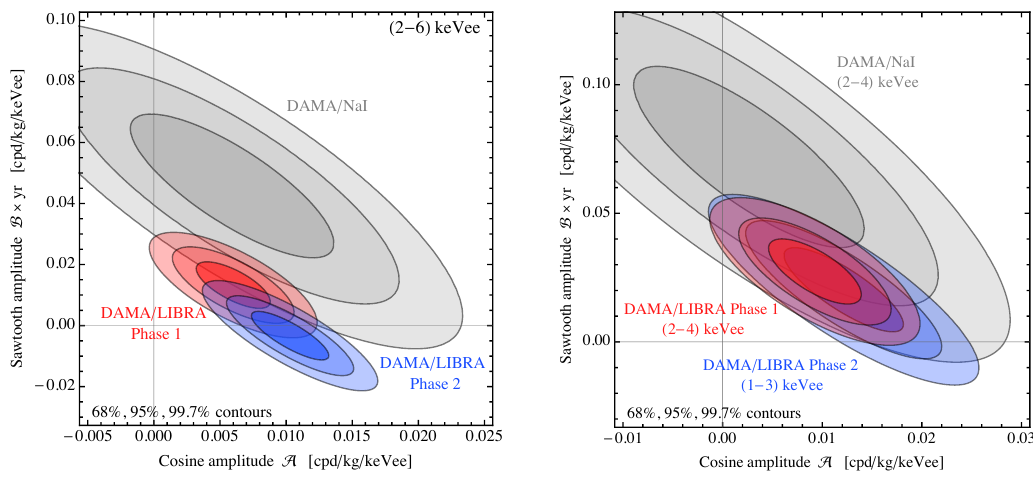
Figure 6 . Fit of the DAMA residual rates to a sawtooth plus a cosine with period and phase as predicted by DM. Left: (cid:12)t of residuals in the (2{ 6) keVee energy window for DAMA/ NaI (gray), DAMA/LIBRA Phase 1 (red) and Phase 2 (blue). Right: (cid:12)t of residuals in the (2{ 4) keVee energy window for DAMA/ NaI (gray) and DAMA/LIBRA Phase 1 (red), and in the (1{ 3) keVee energy window for DAMA/LIBRA Phase